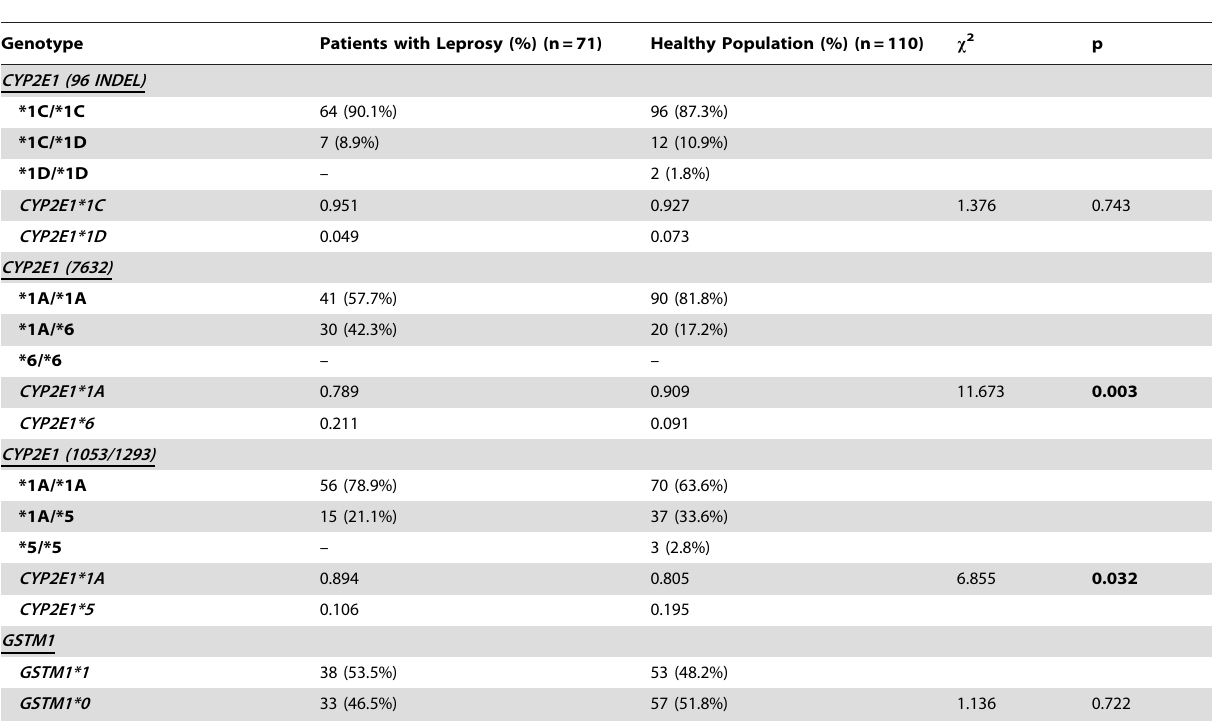
Table 5. Allele and genotype distributions of CYP2E1 and GSTM1 genes within two samples from leprosy patients and healthy